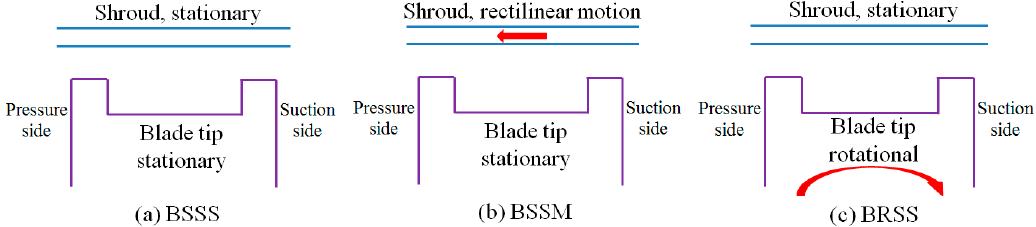
Figure 1. Three simulation models: ( a ) BSSS (blade is stationary and shroud is also stationary); ( b ) BSSM (blade is stationary, but shroud moves along a straight line); ( c ) BRSS (blade is rotating, but shroud is stationary).